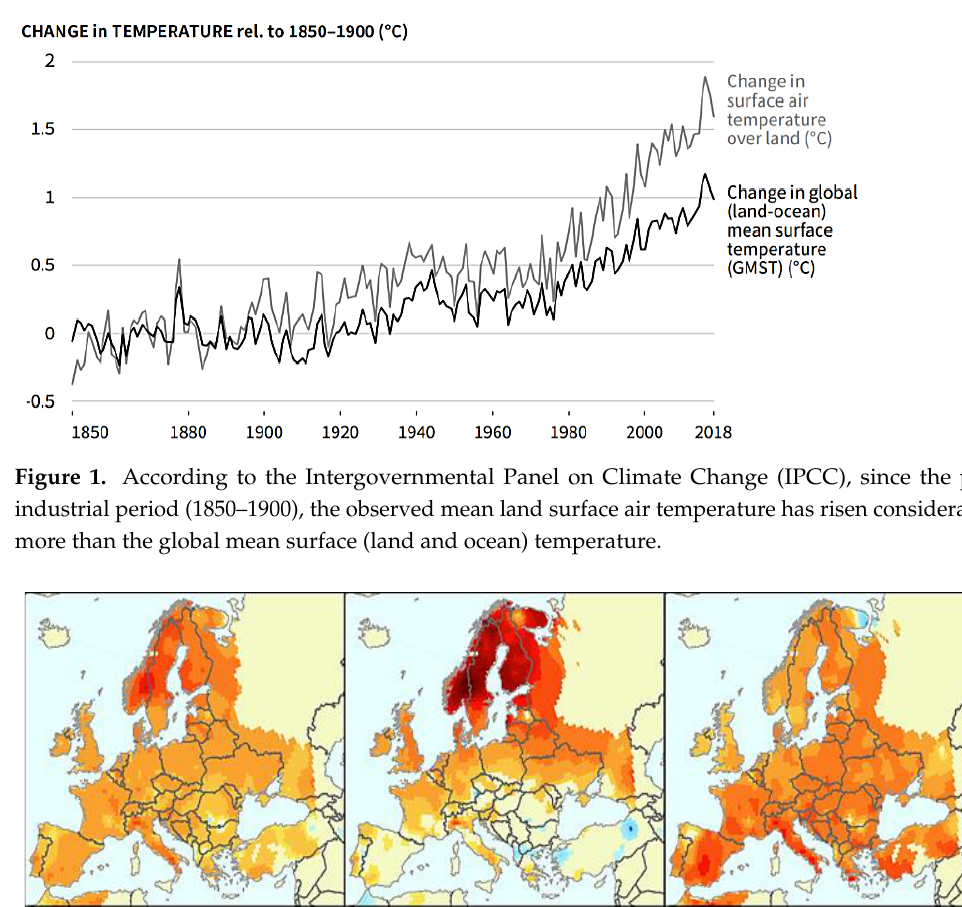
Figure 2. Observed temperature change over Europe during the period 1976 – 2006 according to the European Environment Agency. Reprinted with permission from [6]. Copyright 2021 by the European Environment Agency.